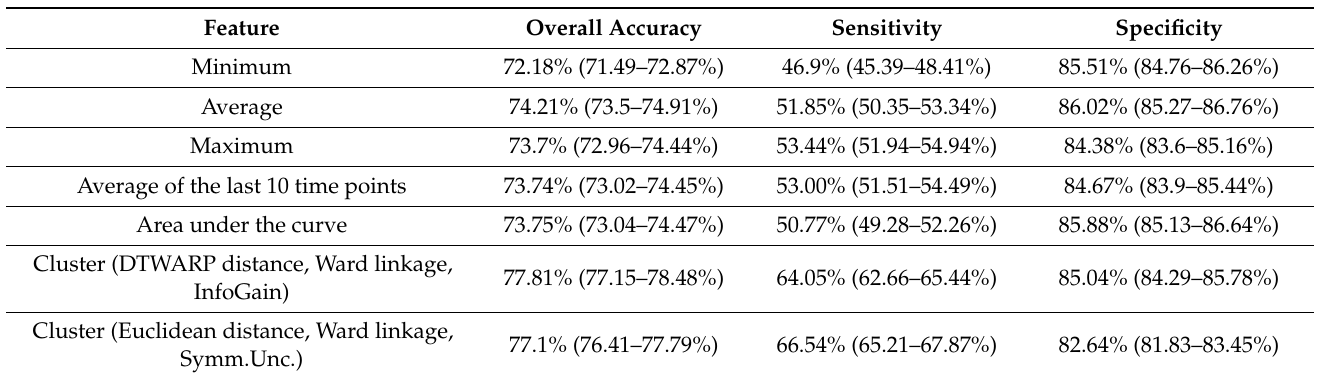
Table 1. Classification results (and 95%CI) using Naïve Bayes